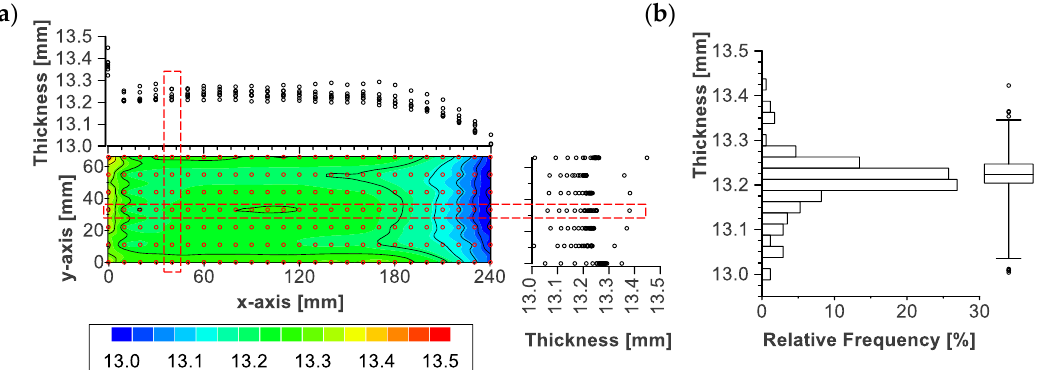
Figure 5. ( a ) Exemplary thickness distribution with the row- and columnwise evaluation of the thickness. ( b ) Transformation of the thickness histogram into a